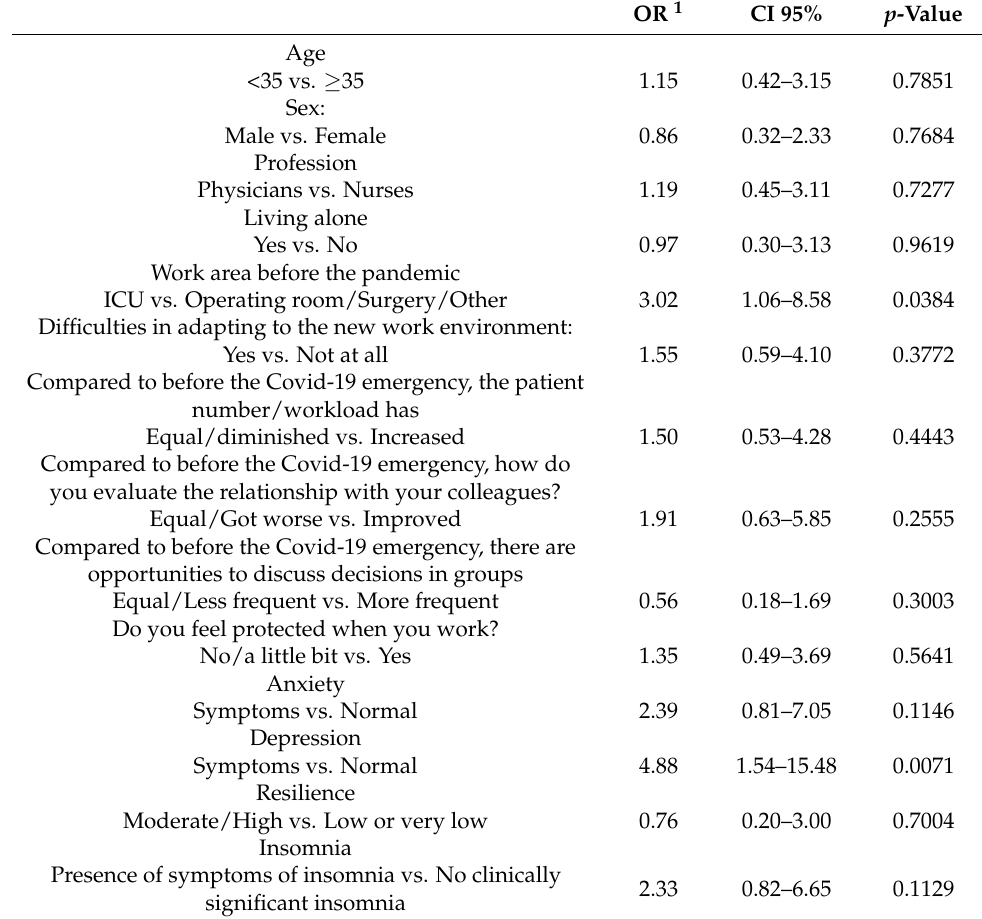
Table 2. Results of logistic regression model (probability of